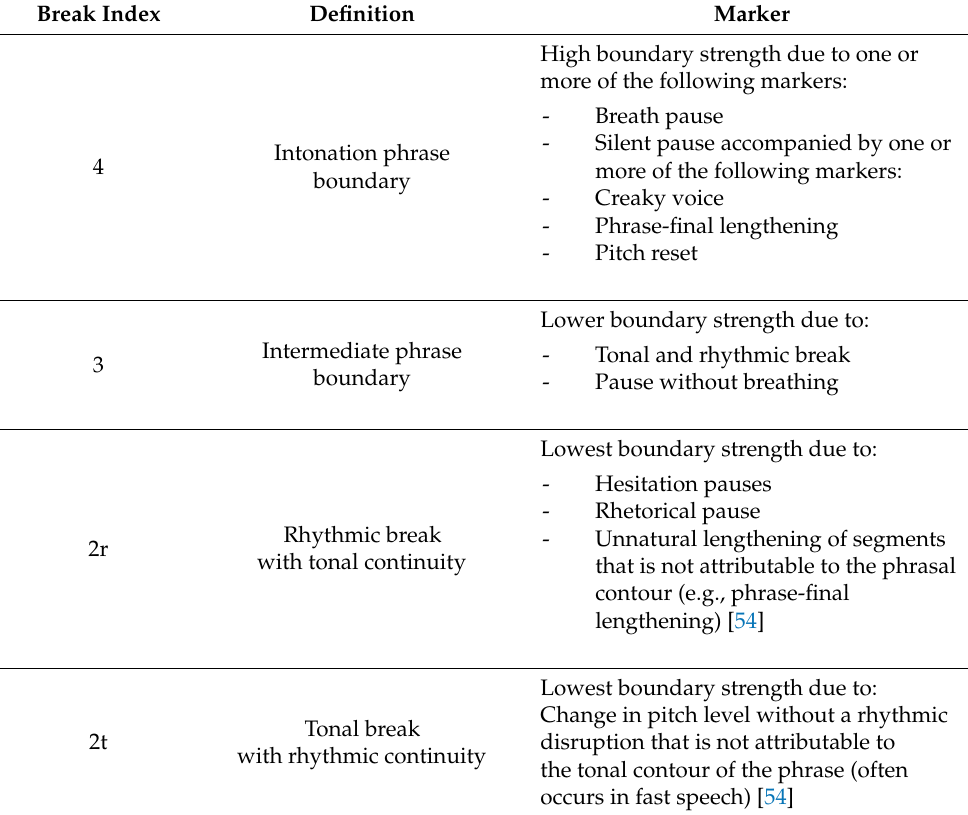
Table 2. Criteria for phrasing analysis and tonal break